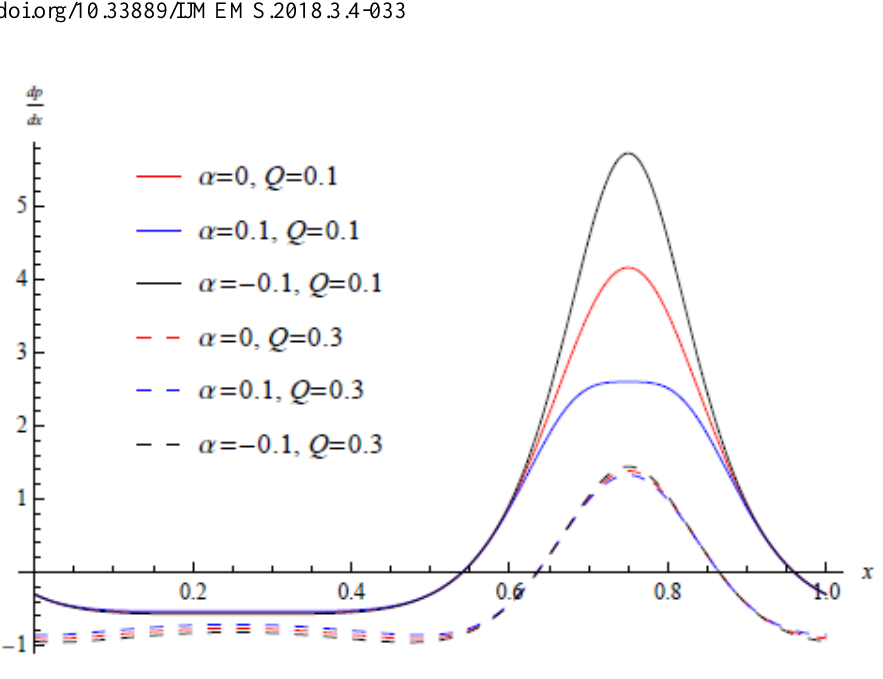
Fig. 6 (a). Pressure gradient for various values of , Q  at